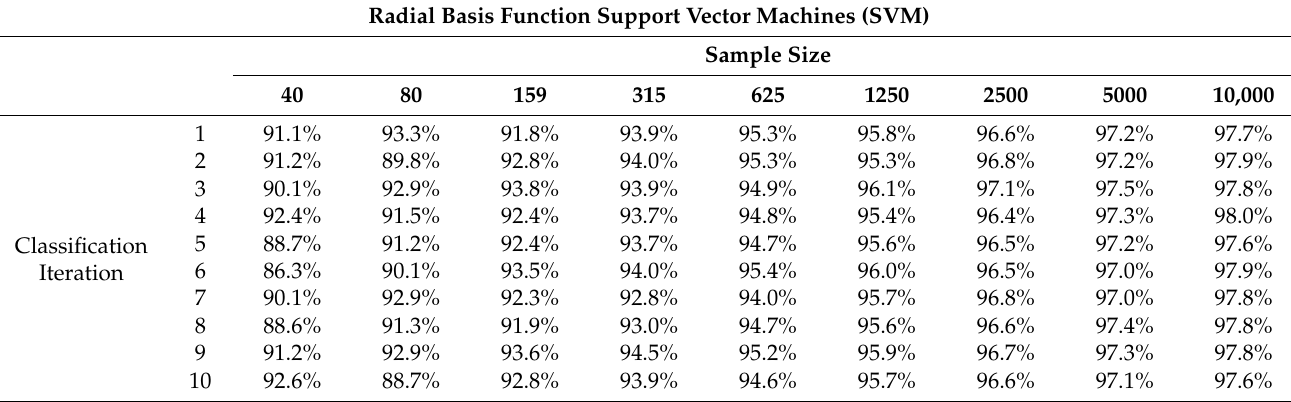
Table A1. Overall Accuracies of Radial Basis Function Support Vector Machines (SVM)